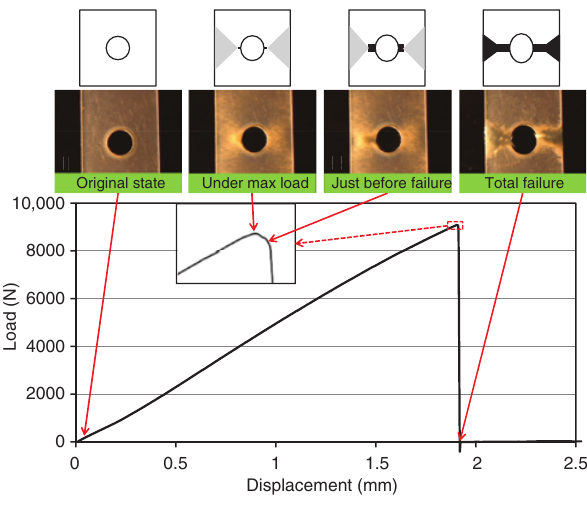
Figure 6 Fracture process of notched